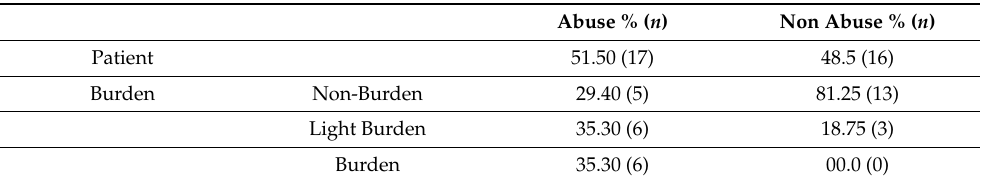
Table 6. Relation between burden in caregiver and abuse ( n = 33).